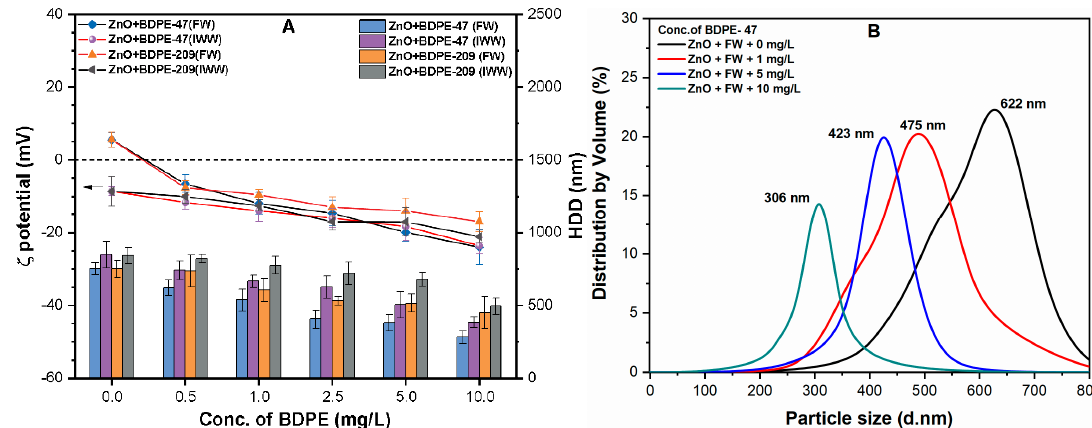
Figure 4. ( A ) The ζ potential and HDD of ZnO NPs coated with different concentrations (0–10 mg/L) of both BDPEs in freshwater (FW) and industrial wastewater (IWW); ( B ) size distribution of ZnO NPs with various BDPE-47 (0, 1, 5, and 10 mg/L) concentrations in FW.